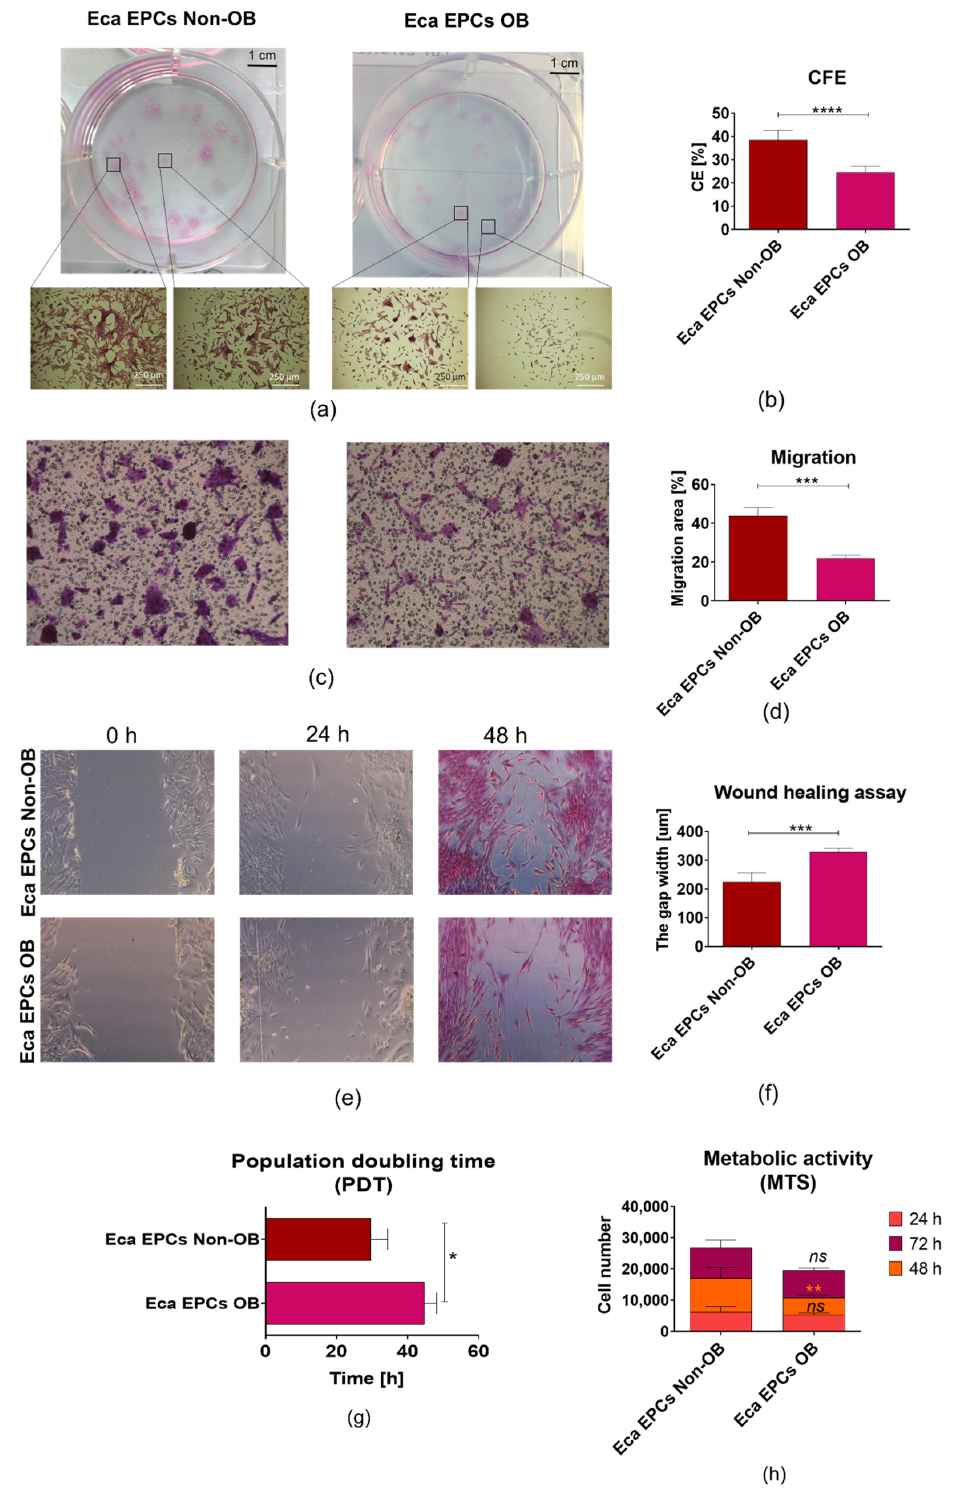
Figure 3. The proliferative capacity of equine endometrial progenitor cells (Eca EPCs) isolated from non-obese mares (non-OB) and obese mares (OB), expressed by colony formation capability ( a , b ), migratory efficiency ( c – f ), population doubling time ( g ), metabolic activity ( h ). Columns with bars represent mean ± SD. * p -value < 0.05, ** p -value < 0.01, *** p -value < 0.001 and **** p -value < 0.0001, while ns symbol refers to non-significant differences.